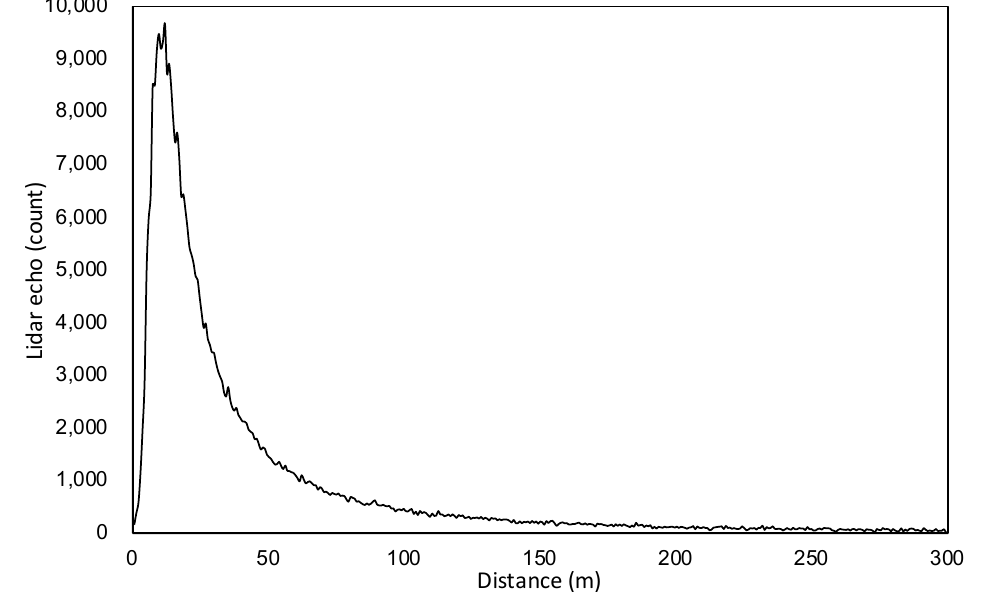
Figure 3. A typical backscattering echo signals from atmospheric